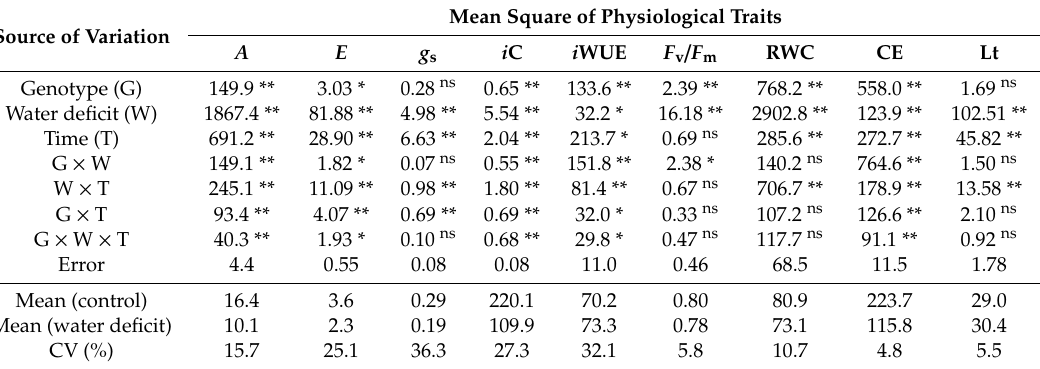
Table 3. Analysis of variance, means, and estimates of experimental coe ffi cients of variation (CV) of physiological traits of four common bean cultivars evaluated under control and water-deficit conditions during four periods (0, 4, 8, and 12 days).